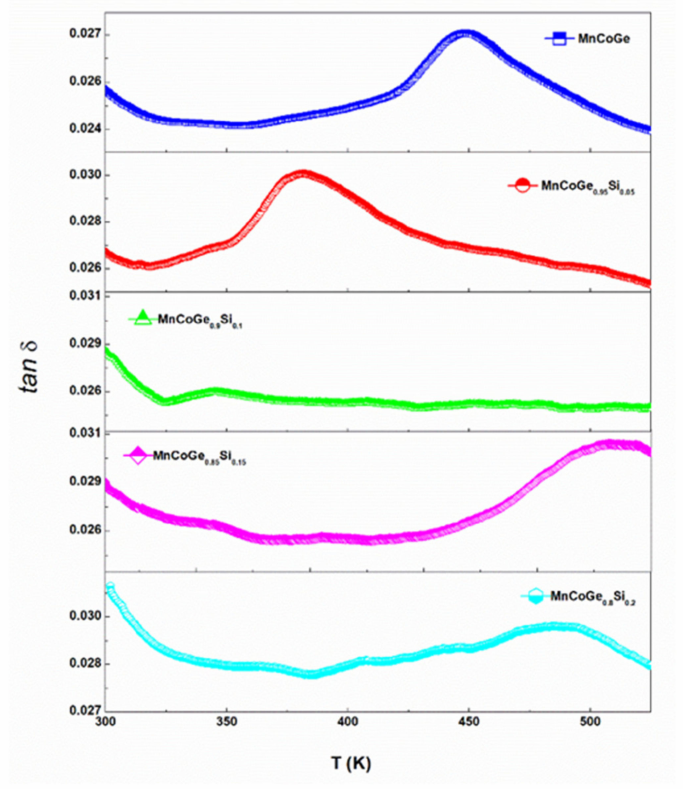
Figure 6. Tan delta measured for MnCoGe 1 − x Si x (x = 0, 0.05, 0.1, 0.15, and